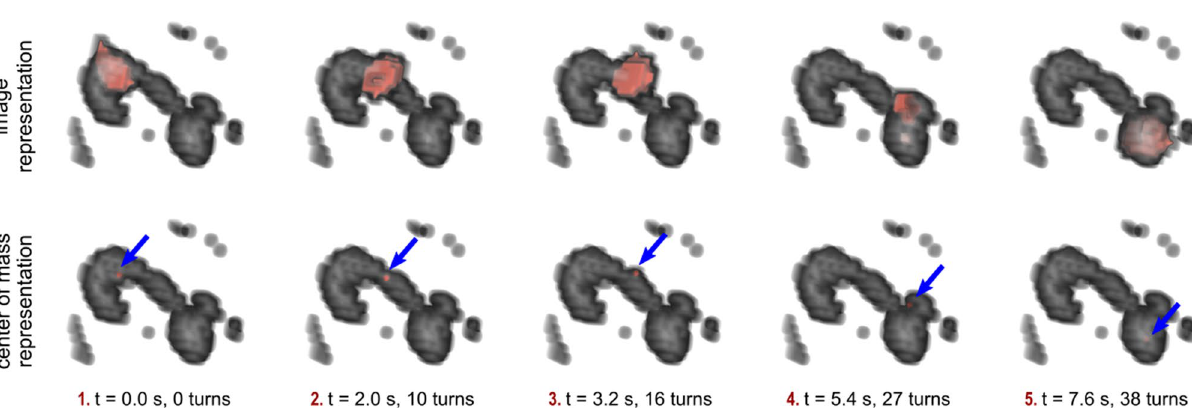
Figure 5. MPI images of the micro-robot inside the aneurysm phantom. Superposition of the reconstructed and registered images of the angiogram and the micro-robot at five positions along the pathway through the middle cerebral artery (see Fig. 4 for path segments). In the bottom row, the calculated center of mass of the micro-robot is